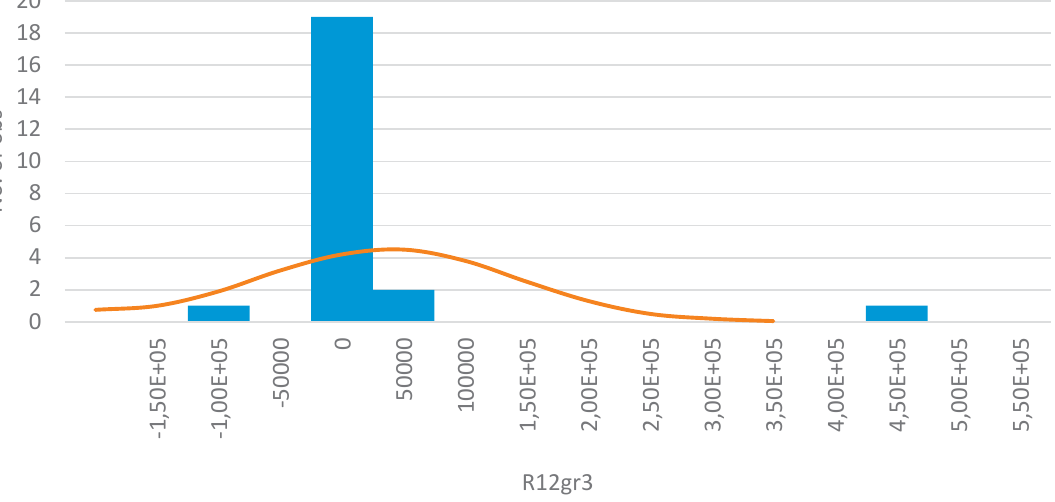
Figure 3. (cid:44)(cid:349)(cid:400)(cid:410)(cid:381)(cid:336)(cid:396)(cid:258)(cid:373)(cid:3)(cid:381)(cid:296)(cid:3)(cid:282)(cid:349)(cid:400)(cid:410)(cid:396)(cid:349)(cid:271)(cid:437)(cid:415)(cid:381)(cid:374)(cid:3)(cid:381)(cid:296)(cid:3)(cid:396)(cid:286)(cid:410)(cid:437)(cid:396)(cid:374)(cid:400)(cid:876)(cid:367)(cid:381)(cid:400)(cid:400)(cid:286)(cid:400)(cid:3)(cid:381)(cid:296)(cid:3)(cid:271)(cid:258)(cid:374)(cid:364)(cid:400)(cid:3)(cid:381)(cid:296)(cid:3)(cid:336)(cid:396)(cid:381)(cid:437)(cid:393)(cid:3)(cid:1007)(cid:3)(cid:349)(cid:374)(cid:3)(cid:1006)(cid:1004)(cid:1005)(cid:1006) (cid:3)